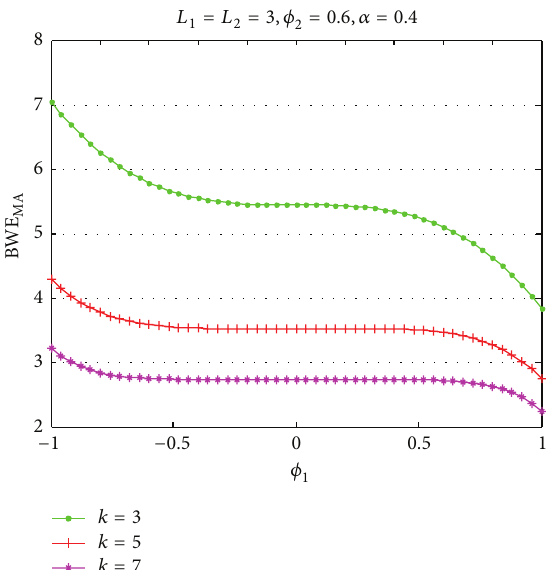
Figure 4: Impact of 𝜙 1 on bullwhip effect for different 𝐿 1 under the MMSE.